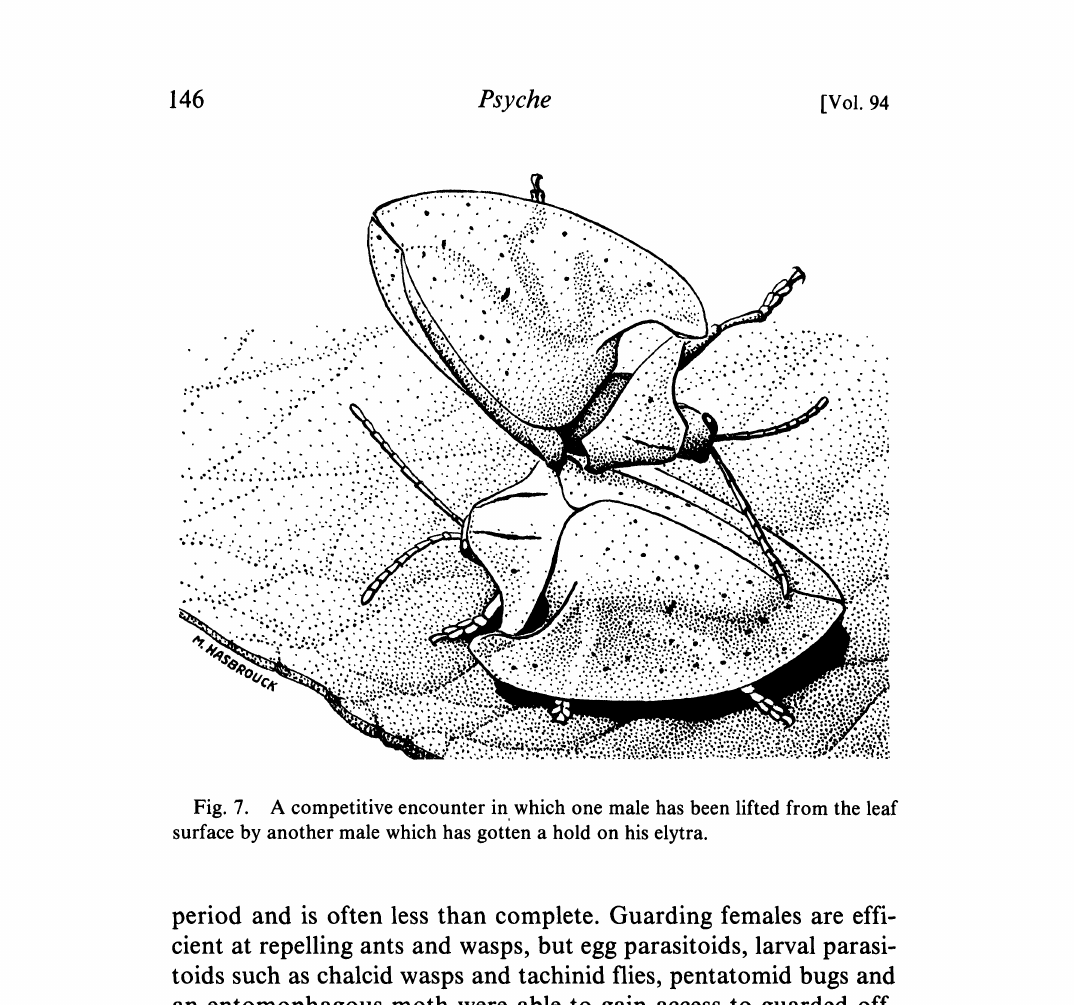
Fig. 7. A competitive encounter in which one male has been lifted from the leaf surface by another male which has gotten a hold on his elytra. period and is often less than complete. Guarding females are effi- cient at repelling ants and wasps, but egg parasitoids, larval parasi- toids such as chalcid wasps and tachinid flies, pentatomid bugs and an entomophagous moth were able to gain access to guarded off- spring. These opportunities arose as groups moved between feeding sites or as individuals temporarily became separated from the rest of the group guarded by the